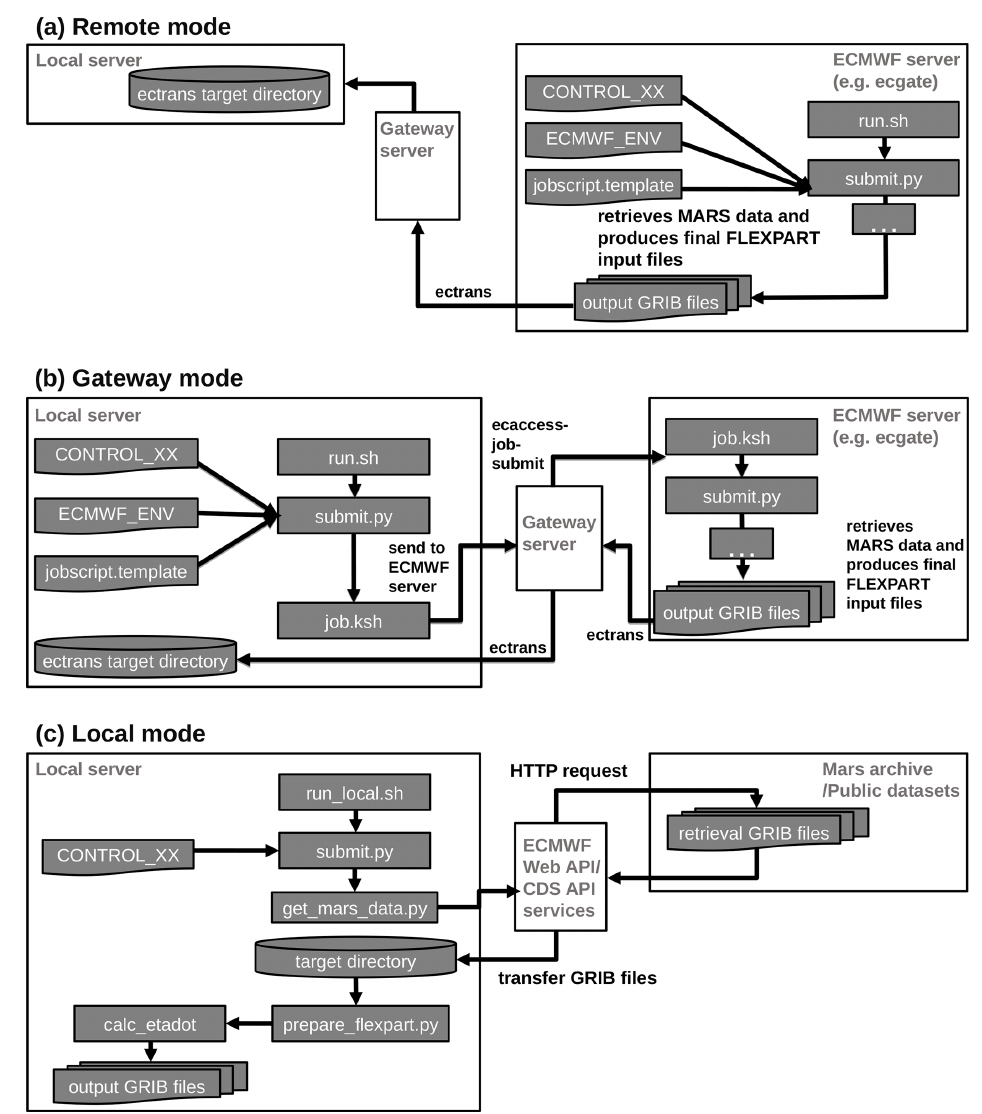
Figure 4. General overview of the workflows and work locations in the different application modes: (a) remote, (b) gateway and (c) local mode. The files and scripts used in each mode are outlined.